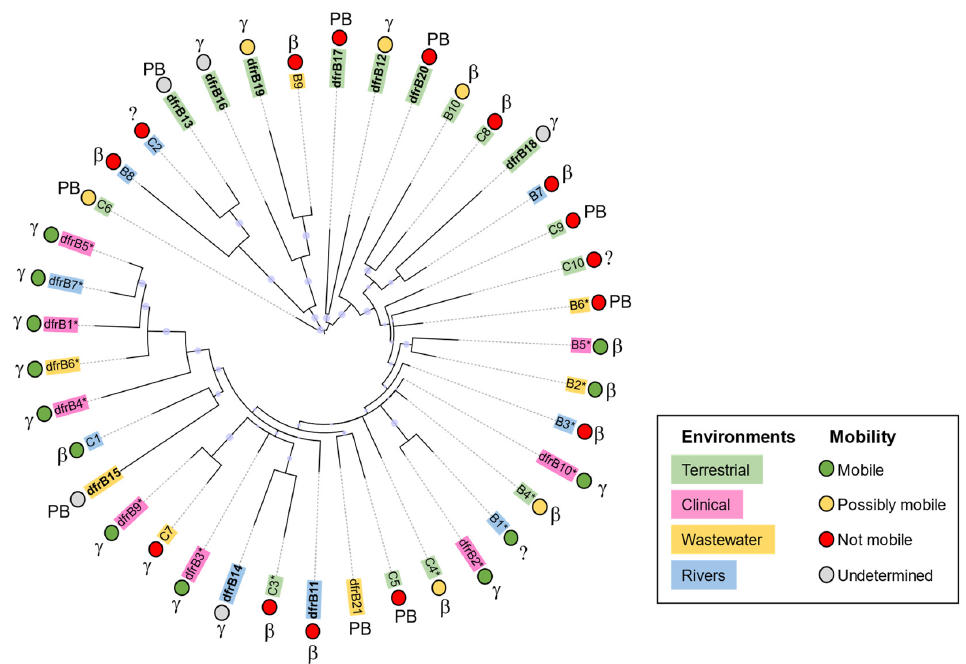
Figure 3. Phylogenetic tree of dfrB1–dfrB21 and associated putative dfrB genes. Sequences are classified according to their source environment, predicted mobility, and taxonomy. Sequences were aligned using MAFFT; the tree was obtained using IQ-tree and visualized with iTOL. Bootstrap confidence levels are indicated by the size of the circle before each node. Information pertaining to source environment, taxonomy, and predicted mobility is reported in Tables 2, 3, and S3. The newly identified dfrB12–dfrB21 are in bold. Sequences associated with MDR are marked with an asterisk (*). Taxonomy: “ β ” for β -Proteobacteria, “ γ ” for γ -Proteobacteria, “PB” for Proteobacteria; “?” indicates undetermined, as taxonomic information was not available in some cases.